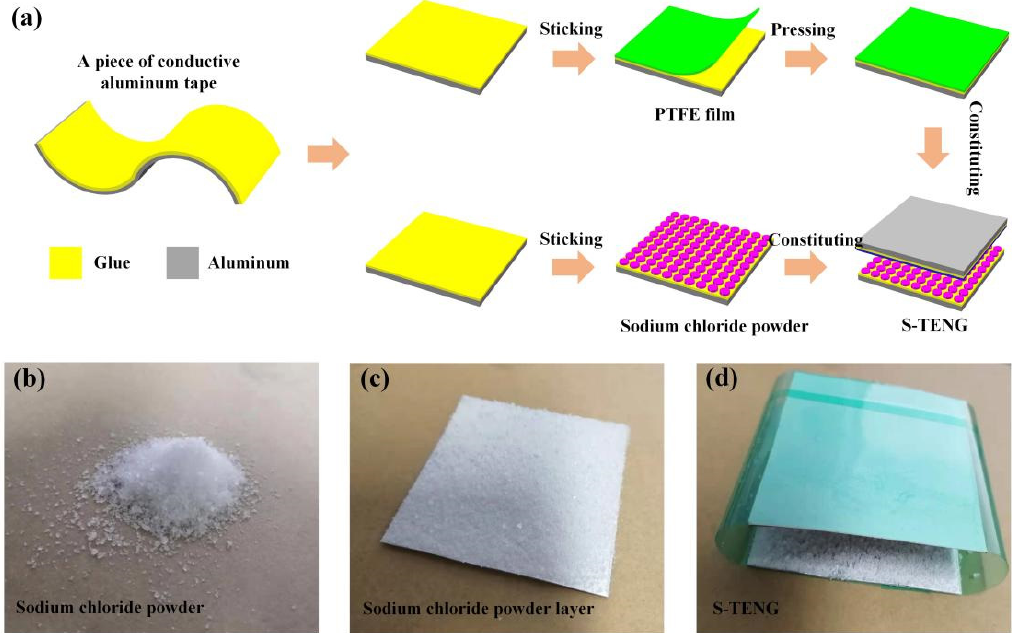
Figure 1. ( a ) The detailed preparation process of S-TENG using aluminum taper, PTFE film and sodium chloride powder. The photograph of ( b ) sodium chloride powder, ( c ) sodium chloride powder layer and ( d ) S-TENG.